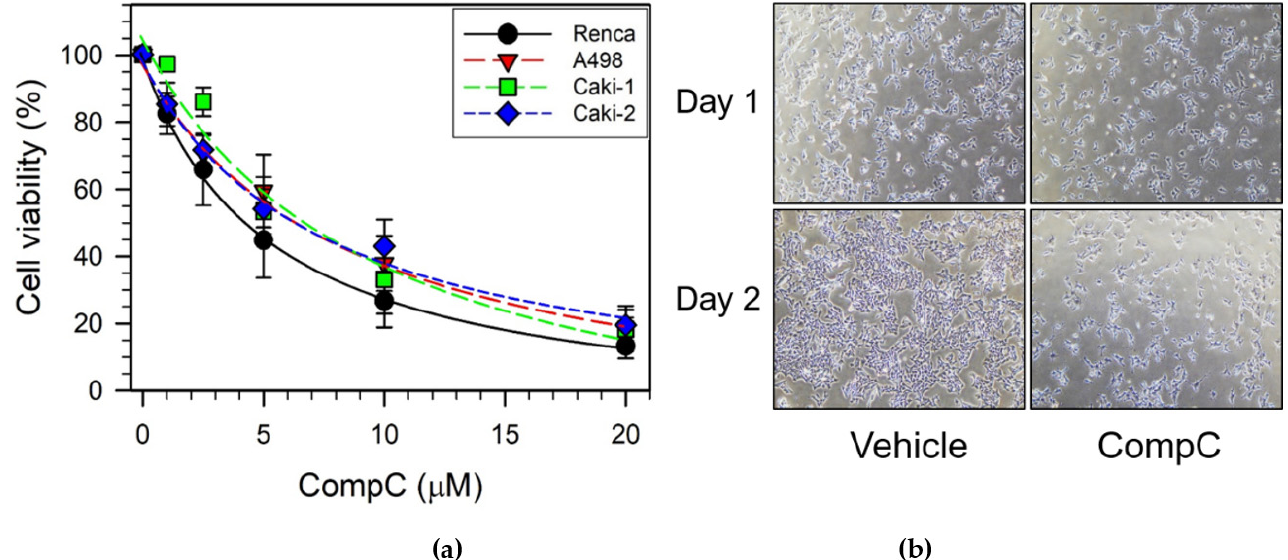
Figure 1. Compound C (CompC) reduced the viability of Renca renal carcinoma cells in a dose-dependent manner. ( a ) Renca, A498, Caki-1, and Caki-2 cells were seeded onto 24-well plates, cultured for one day, and treated with the vehicle, dimethyl sulfoxide (DMSO), or various concentrations of CompC (0, 1, 2.5, 5, 10, and 20 μ M) in the culture media. After two days, a 3-(4,5-dimethylthiazol-2-yl)-2,5-diphenyltetrazolium bromide (MTT) assay was performed and the percentage of cell viability is plotted as the mean ± standard deviation (SD) with n = 20. ( b ) Subconfluent Renca cells were cultured in the presence of vehicle or 10 μ M CompC for one–two days. The cell morphology was observed through and photographed by an inverted microscope (100×).